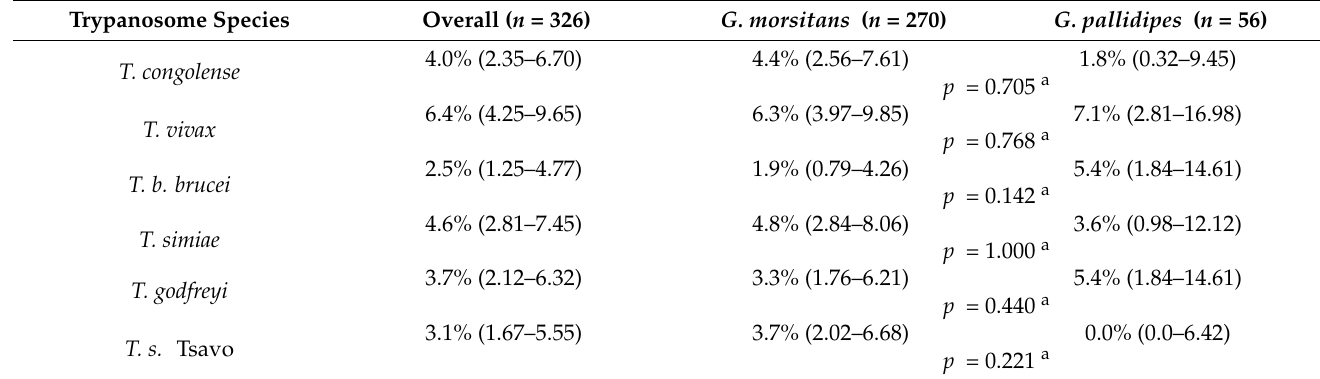
Table 3. Prevalence of trypanosomes species identified according to tsetse fly species.